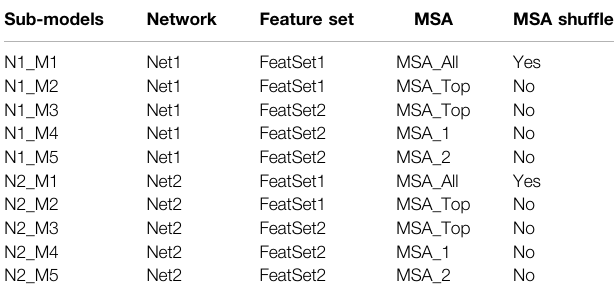
TABLE 1 | The strategies used for the training of sub-models (N1_M1/N1_M2/ N1_M3/N1_M4/N1_M5 are used for DuetDis). Sub-models